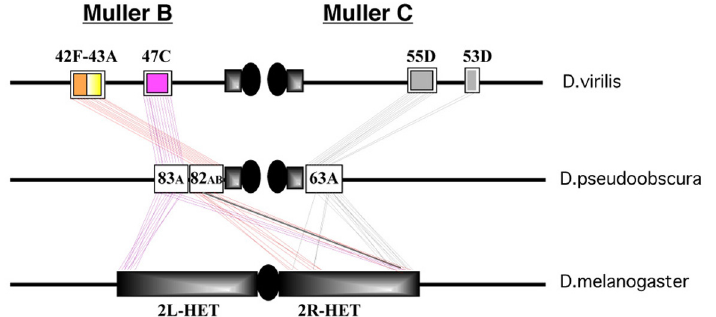
Fig 4. Schematic representation showing the syntenic chromosomal regions of D . virilis and D . pseudoobscura containing the D . melanogaster heterochromatic gene orthologs. Black boxes correspond to heterochromatin regions; black oval shape indicates the centromere.